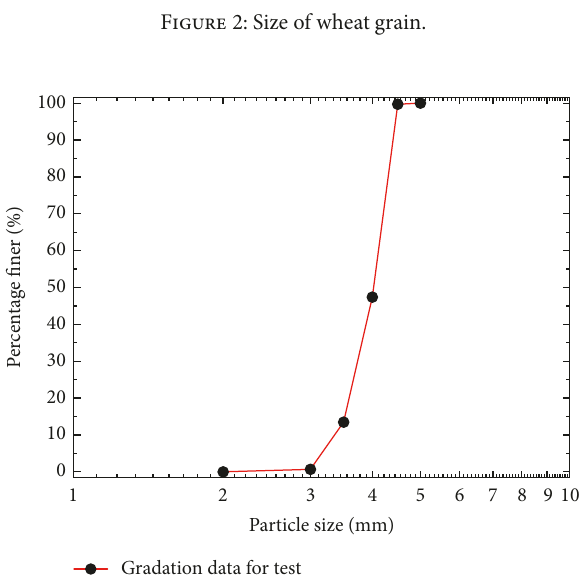
Figure 3: Grain size distribution of wheat